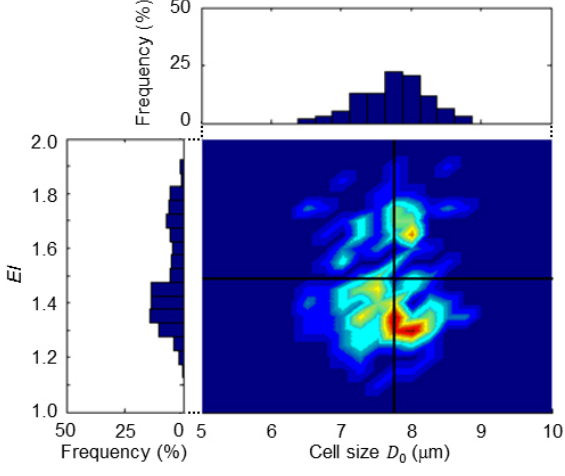
Figure 8. Extensibility map of a subject who received a blood transfusion within 24